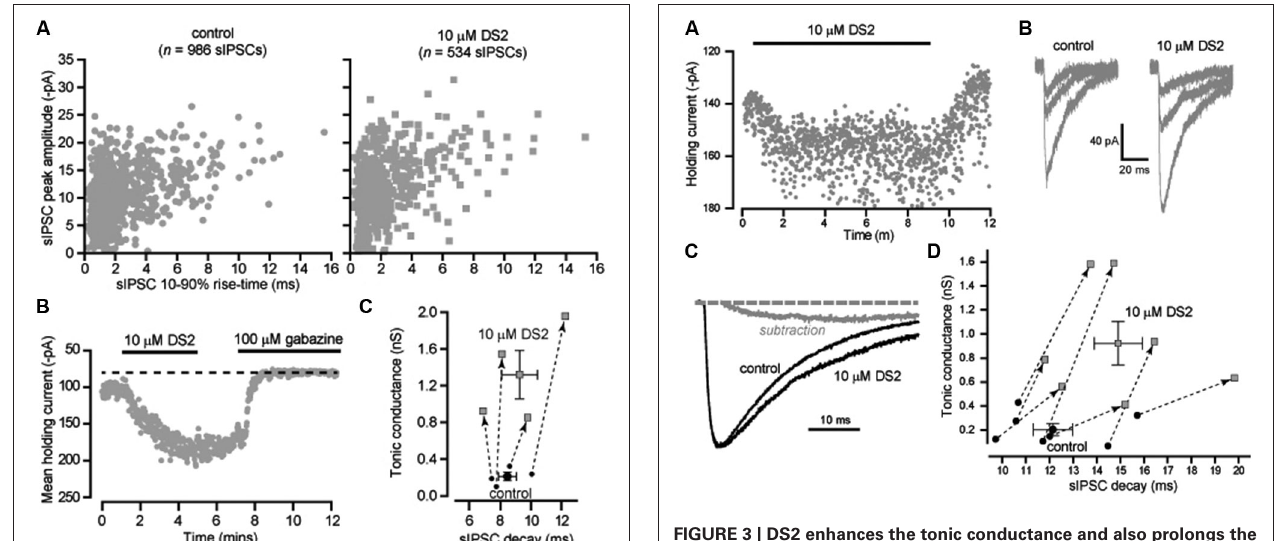
FIGURE 3 | DS2 enhances the tonic conductance and also prolongs the IPSC decay in layer II/III pyramidal neocortical neurons . (A) Plot of the average holding current (V H − 70 mV) calculated every 1 s from consecutive 100 ms epochs (grey circles). The application of 10 µ M DS2 is indicated by the solid black bar. (B) Representative IPSCs detected in control conditions and during DS2 application. (C) Average synaptic waveform constructed from control data and in the presence of DS2. A simple subtraction of these traces has been performed to illustrate the slow rising and slow decaying DS2-sensitive component of the IPSC (grey line). The dashed line indicates the normalised baseline. (D) Scatter plot of the tonic conductance against the IPSC decay for each cell (grey circles) before and after DS2 application (joined by dashed line and arrow). Superimposed on this plot are the average values across all cells (mean ± SEM, n =